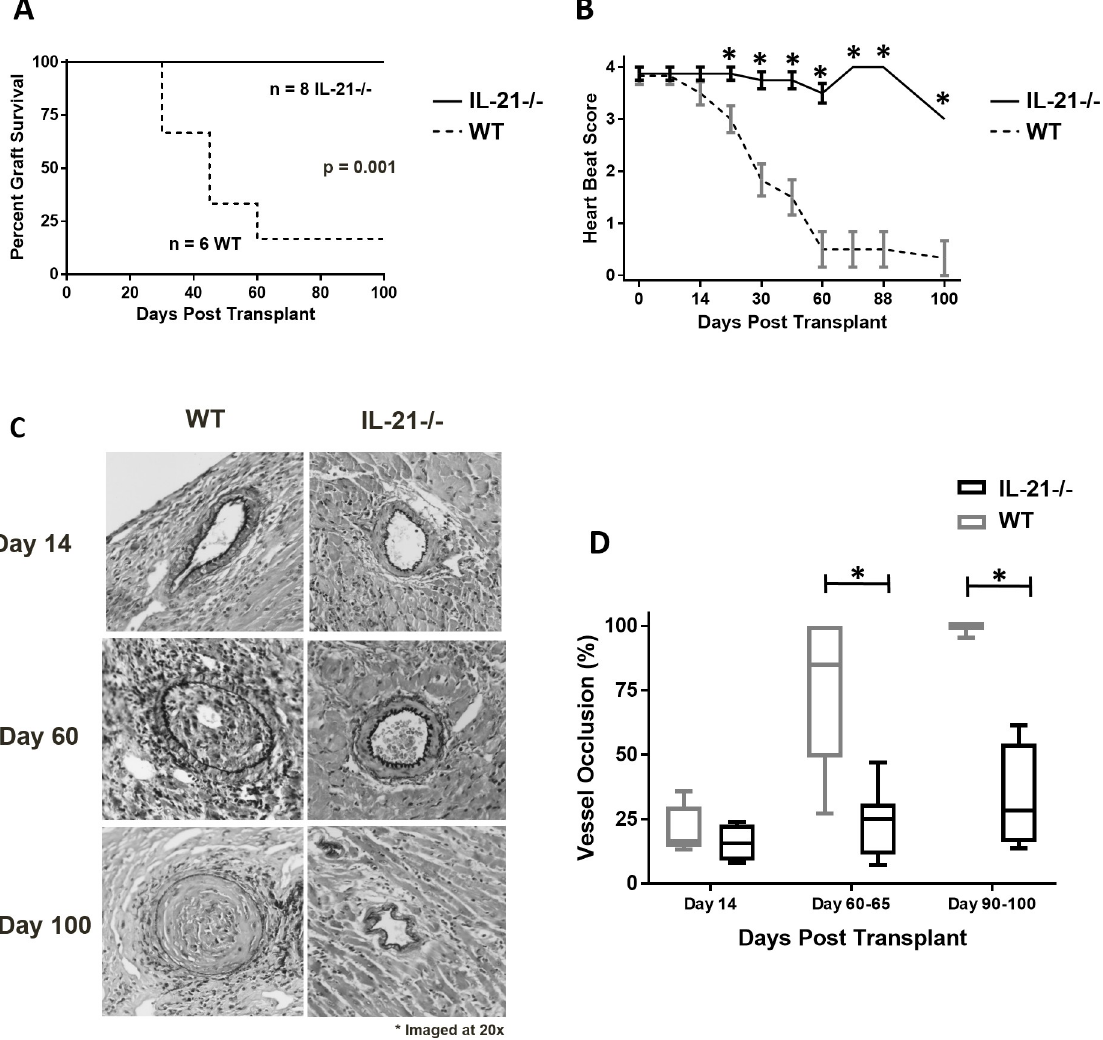
Fig 2. Heart transplant graft evaluation in IL-21-/- mice in a chronic rejection model. Graft survival (A), heart beat scoring (B), and vessel occlusion (C and D) over time in WT and IL-21-/- recipient mice of heart transplants from bm12 mice. Significance approximated by Mantel-Cox test (A), 2-way ANOVA with Bonferroni post-tests (B), and unpaired Student’s t-test (D) � indicates p < 0.05. C) Grafts were recovered on the indicated day, cut, and stained for elastin. D) Percent occlusion was determined by tracing the internal elastic lamina and lumen of each vessel and calculated by % occlusion ¼ ½ Area of internal lamina �(cid:0) ½ Area of lumen � � 100 . The number of mice and vessels were as follows: ½ Area of internal lamina � Day 14 (2 mice per group, 9–10 vessels); Day 35–45 (3–4 mice per group, 11–17 vessels); Day 60–65 (6–7 mice per group, 13–27 vessels); Day 90–100 (2 mice per group, 6–8 vessels).